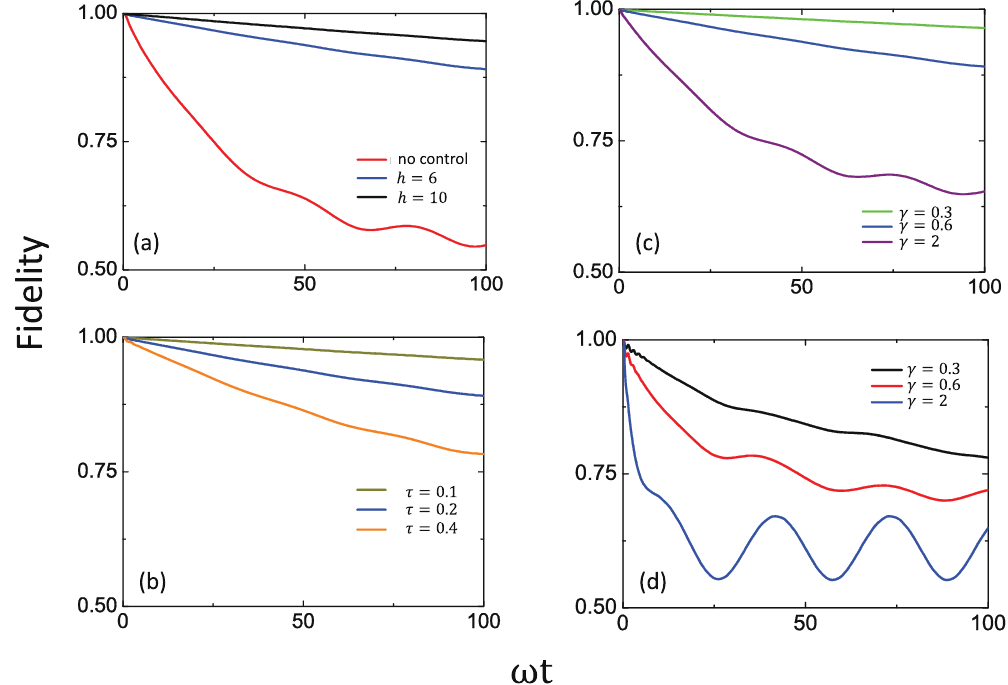
Figure 3. Fidelity evolution of the dark state in the presence of the control pulses. ( a ) Fidelity of the dark state when varying the strength of the pulse, where the period of the pulses is τ = . 0 2 and the duration of each pulse is ∆ = . 0 1 . The parameters of the two baths are Γ = 0.1 and γ = 0.6. ( b ) Fidelity of the dark state when varying the period of the pulses, where the strength of the pulse is = . ∆ h 0 6/ and the duration is chosen to be τ ∆= . 0 5 . The parameters of the two baths are also Γ = 0.1 and γ = 0.6. ( c ) Fidelity of the dark state when varying the inverse of the bath correlation time γ , where the strength of the pulse is h = 6, the period of the pulses is τ = 0.2, and the duration of each pulse is ∆= . 0 1 . The coupling strength of each bath is Γ = 0.1. ( d ) Fidelity of the dark state when varying the inverse of the bath correlation time γ , where the coupling strength of each bath to the system is Γ = 1. Other parameters are the same as in ( c